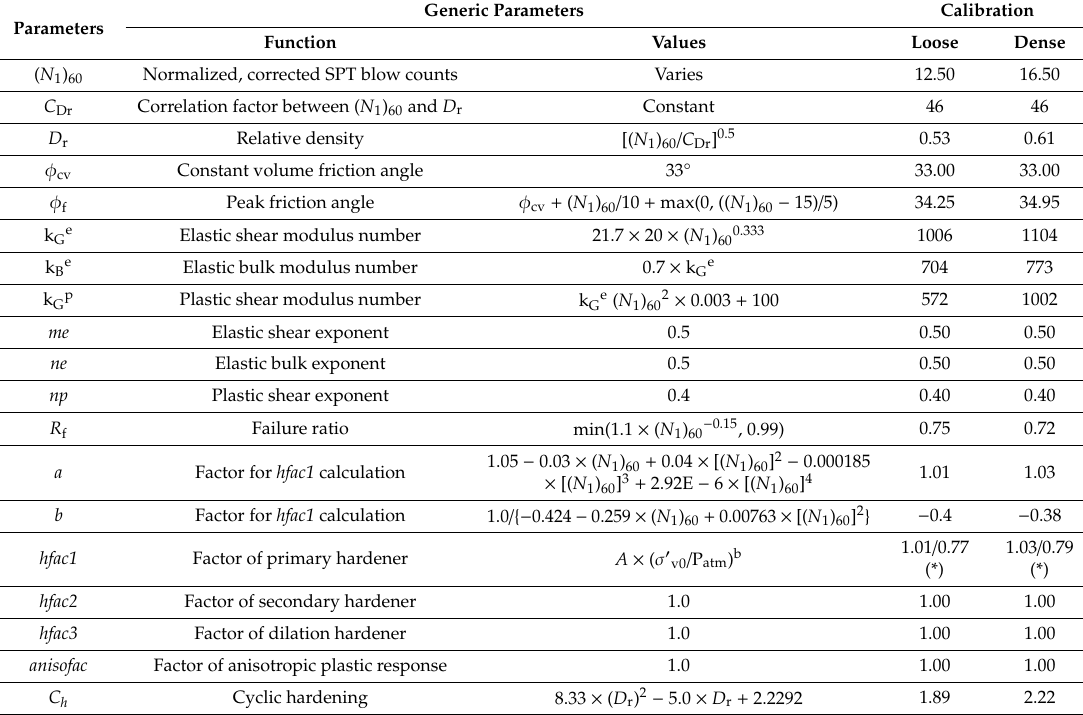
Table 1. Input parameters of the UBCSAND2 model for Pohang sand by CDSS tests.